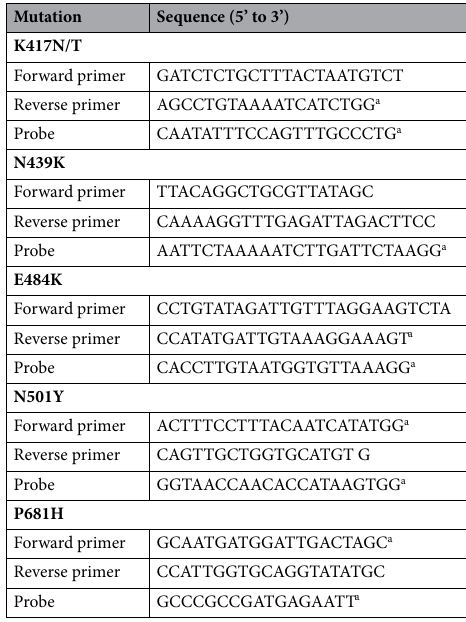
Table 1. Primer and probe sequences for the RT-qPCR melting curve analysis assays. The probes are dual probes with fluorophore in 5’ end and quencher in 3’ end. a Modified with Intercalating Nucleic Acid ® (INA ® )